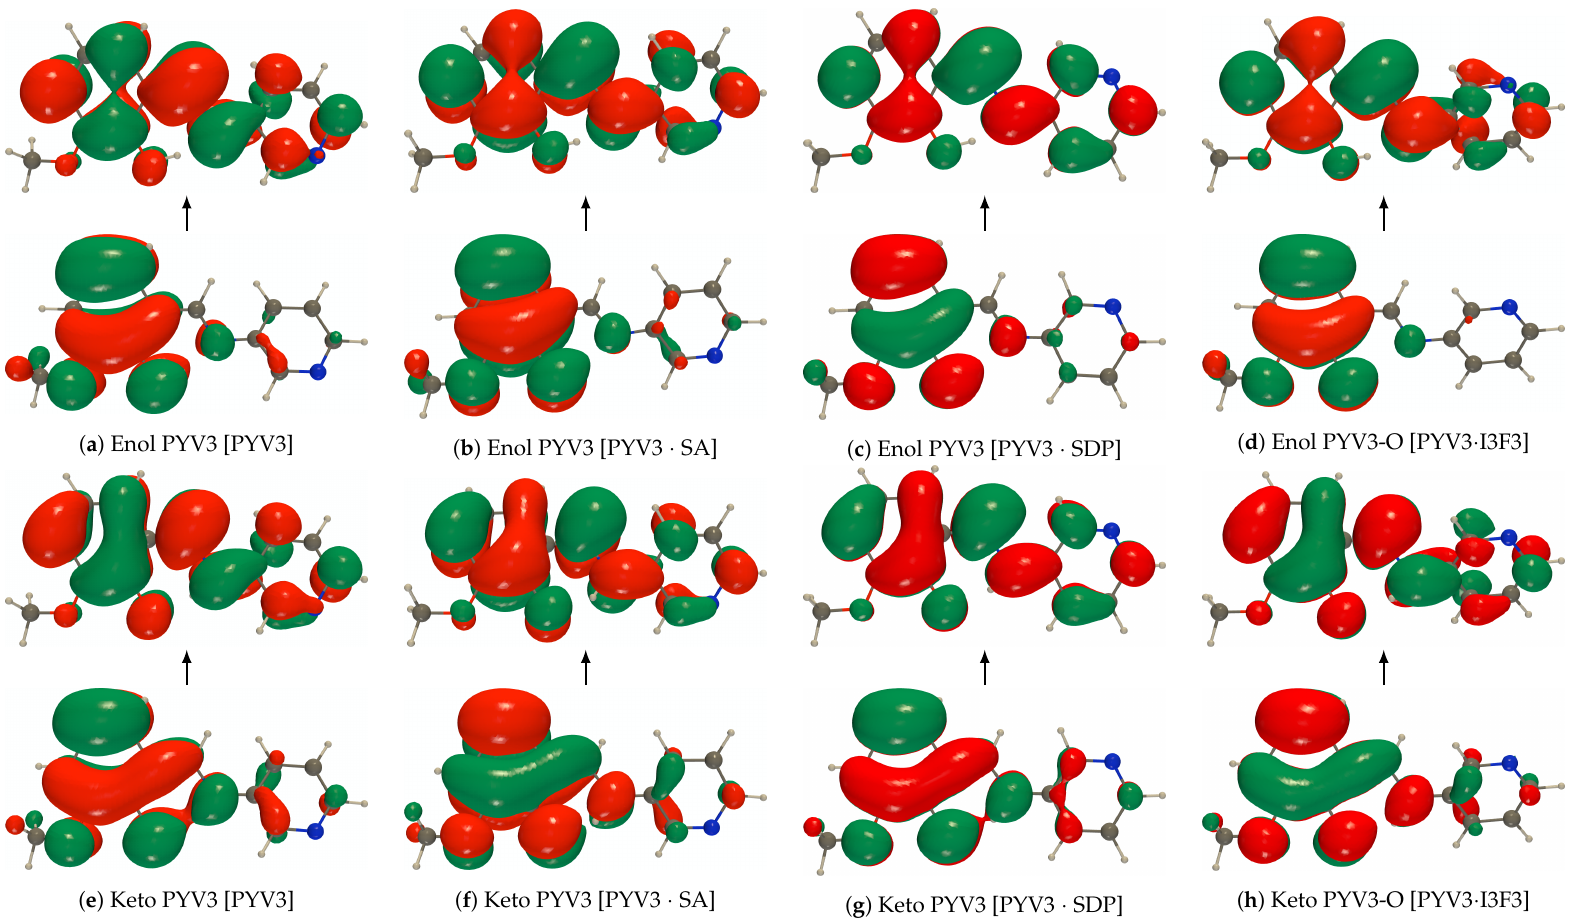
Figure 6. RI-CC2/def2-TZVPD NTOs (holes below the arrows and particles above them, the red (green) lobes are the positive (negative) ones) of the first excited state of isolated monomers of PYV3, PYV3 · SA, PYV3 · SDP, and PYV3 · I3F3 (isovalue of